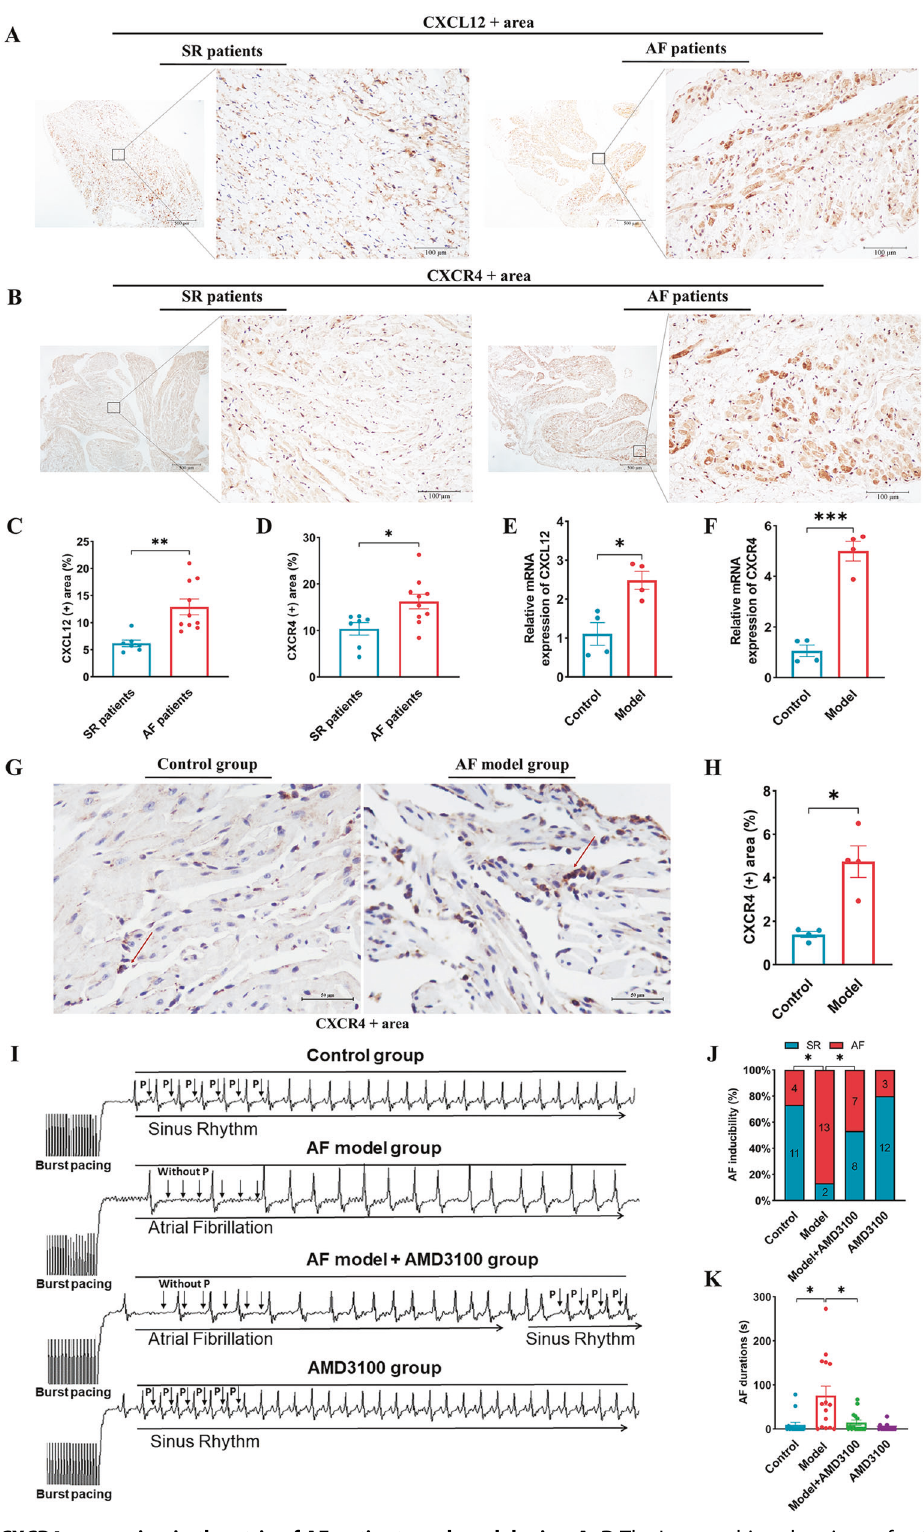
Fig. 3 CXCL12 and CXCR4 expression in the atria of AF patients and model mice. A – D The Immunohistochemistry of atrial of control and AF patients with anti-CXCL12 and CXCR4 antibody (SR, n = 7; AF, n = 10). E – F The qPCR analysis of the mRNA levels of chemokines CXCL12 and CXCR4 in the atria of control and AF model mice ( n = 4). G – H The Immunohistochemistry of atrial of control and AF model mice with anti- CXCR4 antibody ( n = 4). I – K AMD3100 administration prevents the induction of AF. I The representative surface electrocardiogram after the transesophageal atrial burst pacing. J Percentage of successful AF induction ( n = 15). K Duration of AF in mice after AF induction ( n = 15). SR Sinus rhythm, AF atrial fi brillation, Scale bar: 50 μ m, Results are expressed as the mean ± SEM, and n represents the number of animals in each group. * P < 0.05, ** P < 0.01, *** P <